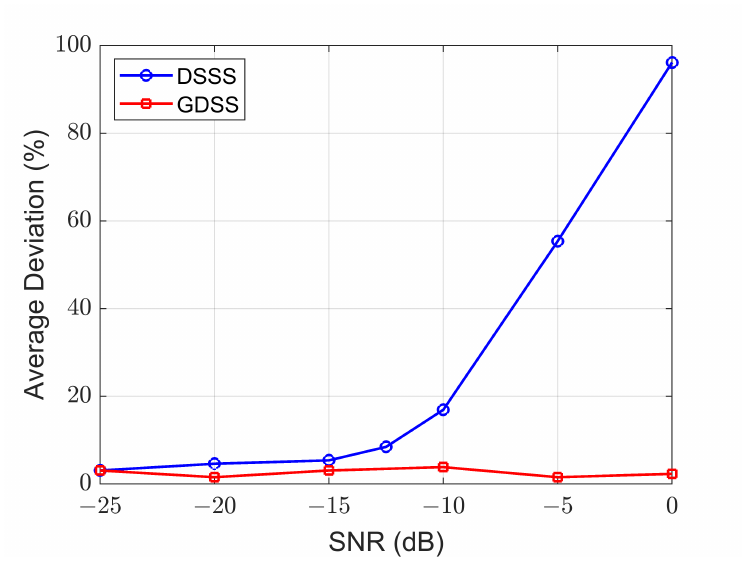
Figure 8. Average deviation of the estimated 20th-order moment from theory for N = 256.